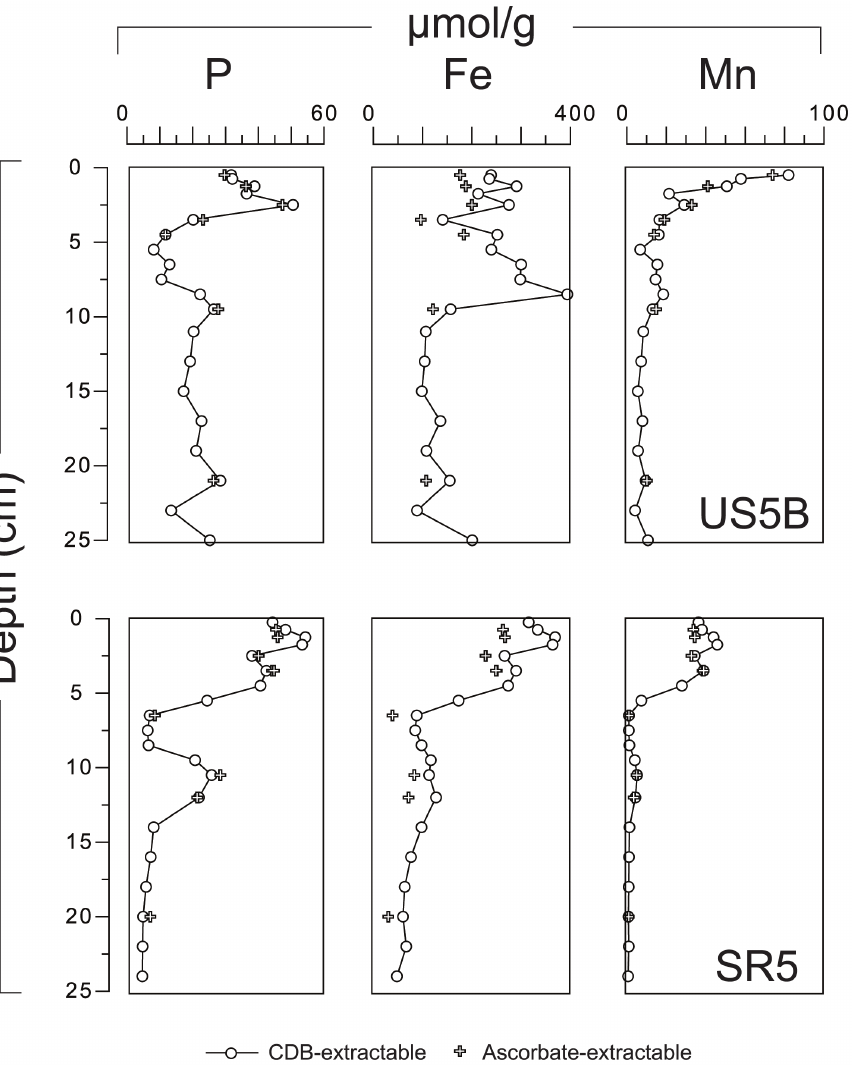
Figure 6. Depth profiles of sediment P, Fe and Mn (in m mol/g). Sediments for sites US5B and SR5 were extracted with CDB (filled circles) and ascorbate (open circles).